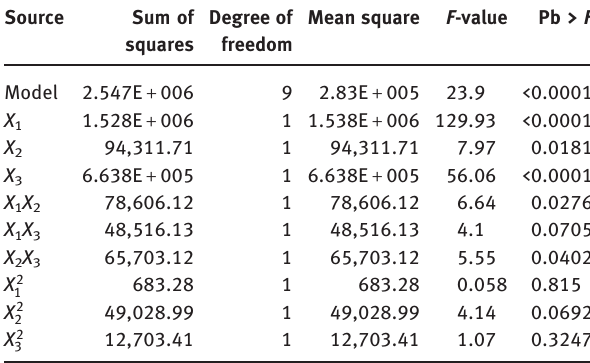
Table 3: Analysis of variance for the iodine number.